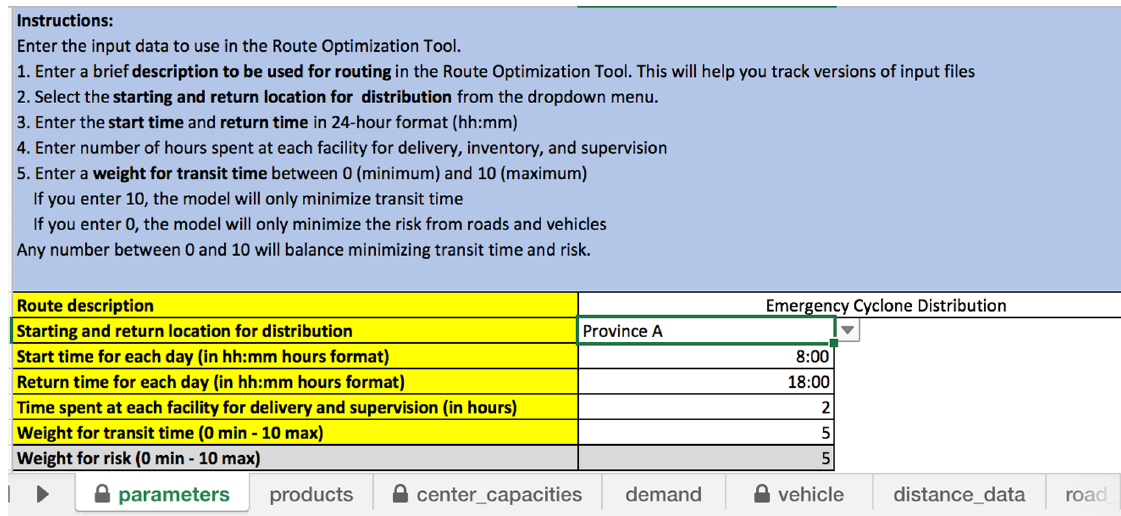
Figure 1. Spreadsheet for “parameters” input sheet, including the start and return location and